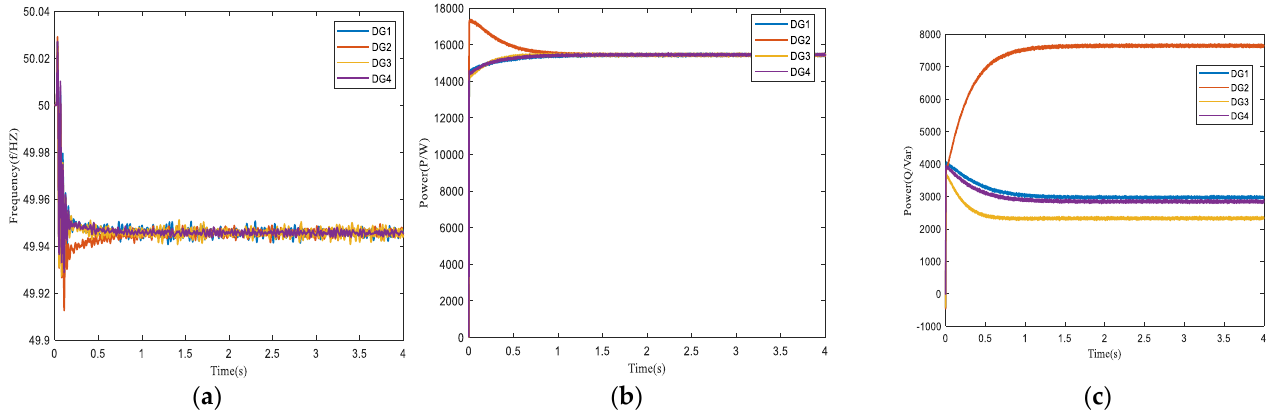
Figure 13. Parameter Results of Secondary Control System Used in Microgrid System ( a ) Frequency variation of the system ( b ) Variation of active power of the system ( c ) Variation of reactive power of the system.